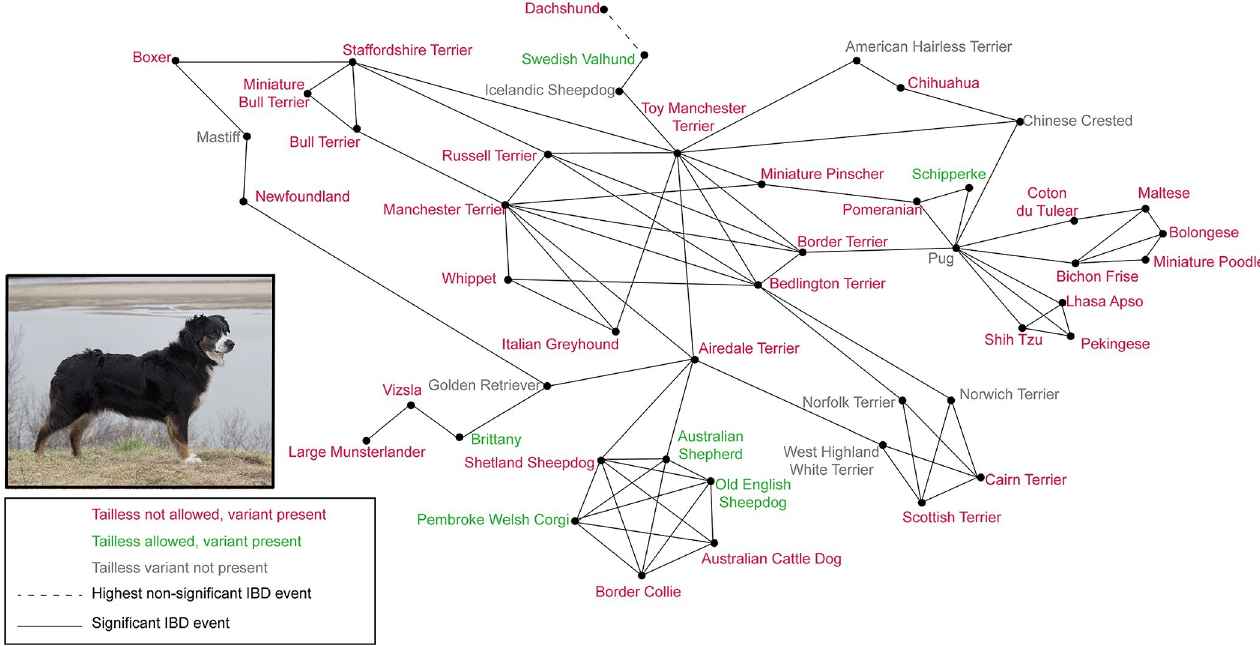
Fig 3. Identity-by-decent (IBD) haplotype sharing breed relationships connect breeds carrying the T allele for tailless . Solid black lines represent instances of significant haplotype sharing levels between breeds. The color of the breed names reflects the proposed carrier status of the tailless variant in the sampled members of those breeds, indicating not present (grey), present and permitted within the breed standard (green), and present and not permitted within the breed standard (red). The Dachshund breed shows no significant haplotype sharing with any other breed, however, its highest non-significant haplotype sharing value is with the Swedish Valhund (dashed line). Inset, the Australian Shepherd breed permits natural taillessness.